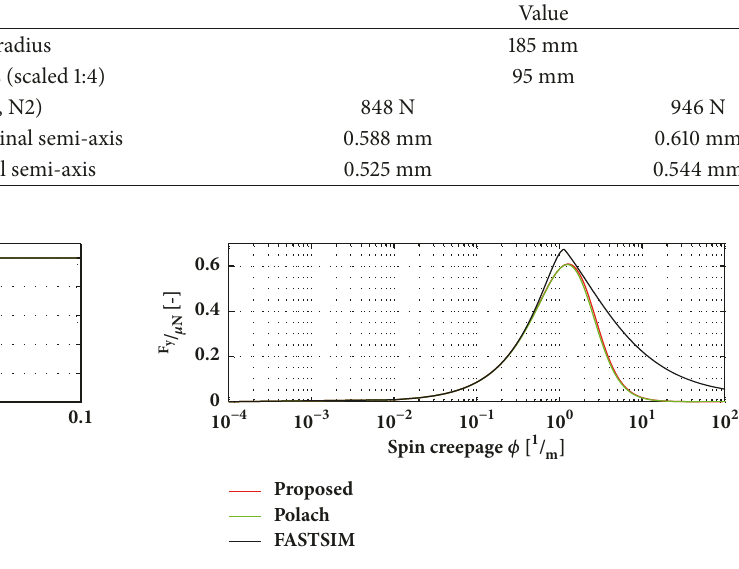
Figure 5: Lateral force versus pure spin